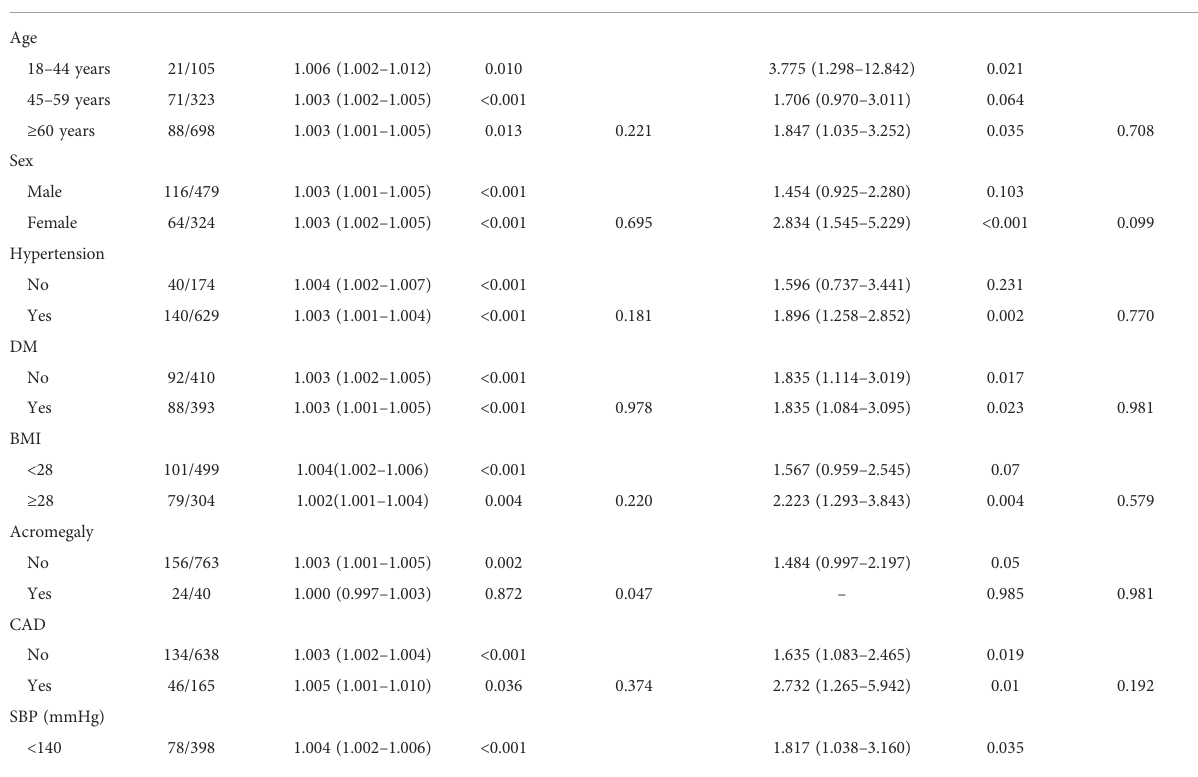
TABLE 3 Association between insulin-like growth factor-1 and interventricular septal thickening in various subgroups.